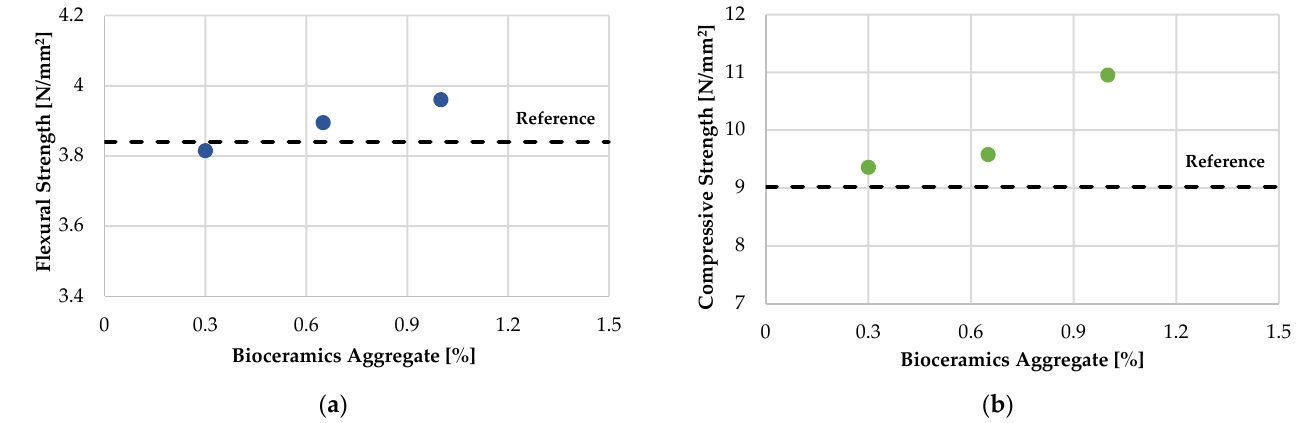
Figure 5. Mechanical properties of gypsum plasters ( a ) Flexural strength results; ( b ) Compressive strength values.